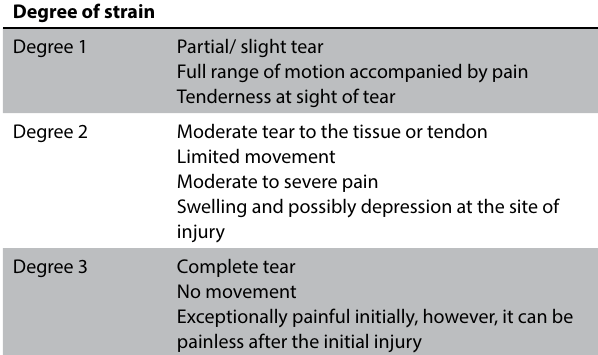
Table 3: Classification of